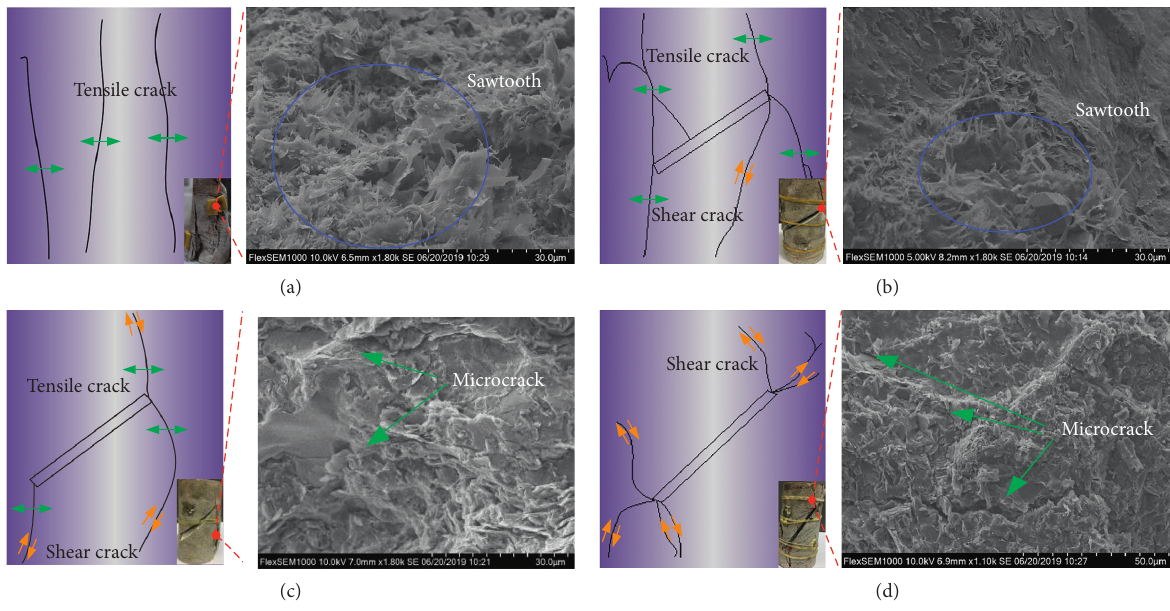
Figure 9: SEM images of fracture morphology and fracture surfaces of typical intact (a) and precracked rock specimens with a dip angle of 30 ° (b), 45 ° (c), and 60 °